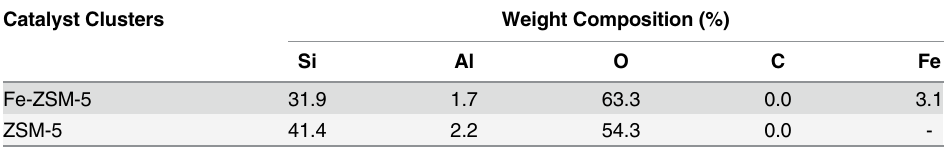
Table 1. EDX analysis of ZSM-5 and Fe-ZSM-5. Catalyst Clusters